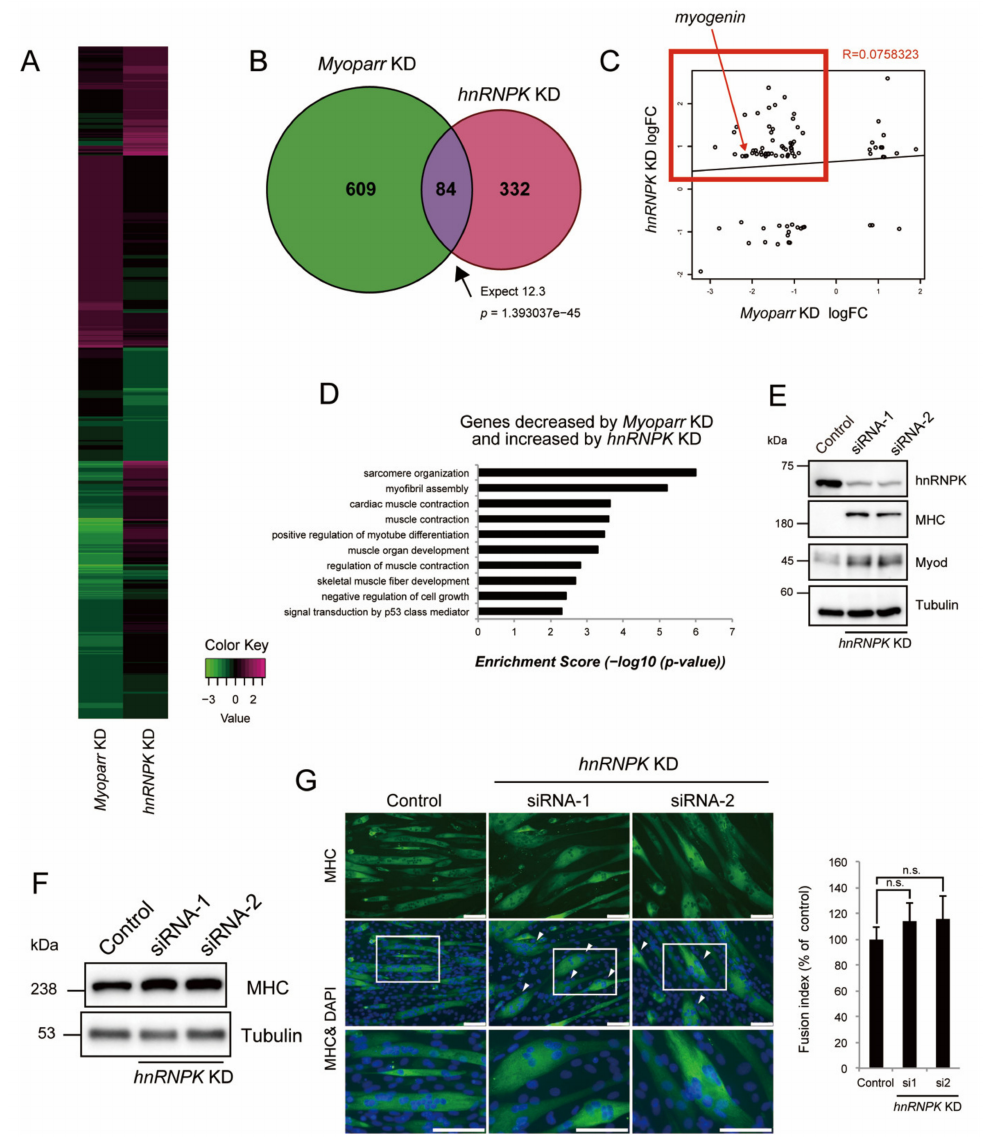
Figure 4. hnRNPK inhibits myogenic differentiation but is required for normal myotube formation. ( A ) A heatmap diagram showing the increased or decreased expression of genes regulated by Myoparr KD and hnRNPK KD. ( B ) The intersection of genes regulated by Myoparr KD and hnRNPK KD shows a significant (Fisher’s exact test) overlap, which is 12.3 times larger than would be expected by chance alone. ( C ) Eighty-four genes with expression levels that were significantly altered by both Myoparr KD and hnRNPK KD showed an uncorrelated pattern (R = 0.0758323, log 2 ratio scale). The red frame indicates the 50 genes for which the expression was decreased by Myoparr KD, but increased by hnRNPK KD. ( D ) Enrichment GO categories of the 50 genes corresponding to the red frame in ( C ). ( E ) Western blots showing increased MHC and Myod expression in C2C12 cells 48 h after hnRNPK KD. Blots are representative of three repeats. ( F ) Western blot showing the increased expression of MHC in C2C12 myotubes 96 h after hnRNPK KD. The tubulin expression served as an internal control. The blots shown are representative of three experiments. ( G ) Immunocytochemistry for MHC 96 h after hnRNPK KD. Nuclei were counterstained with DAPI. Arrowheads in the middle panels indicate locally spherical myotubes. The bottom panels are magnified views of the boxed regions in the middle panels. Bar, 100 µ m. The fusion index is shown as the percent of the control. n = 3, mean ± SD. n.s., not